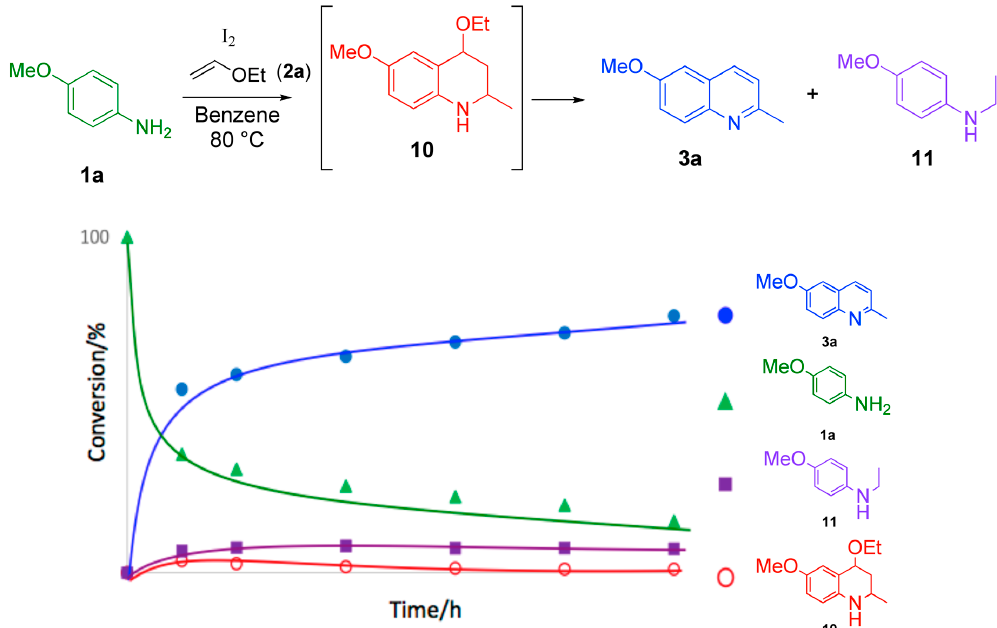
Figure 1. Monitoring the reaction of 1a and 2a by 1 H-NMR.